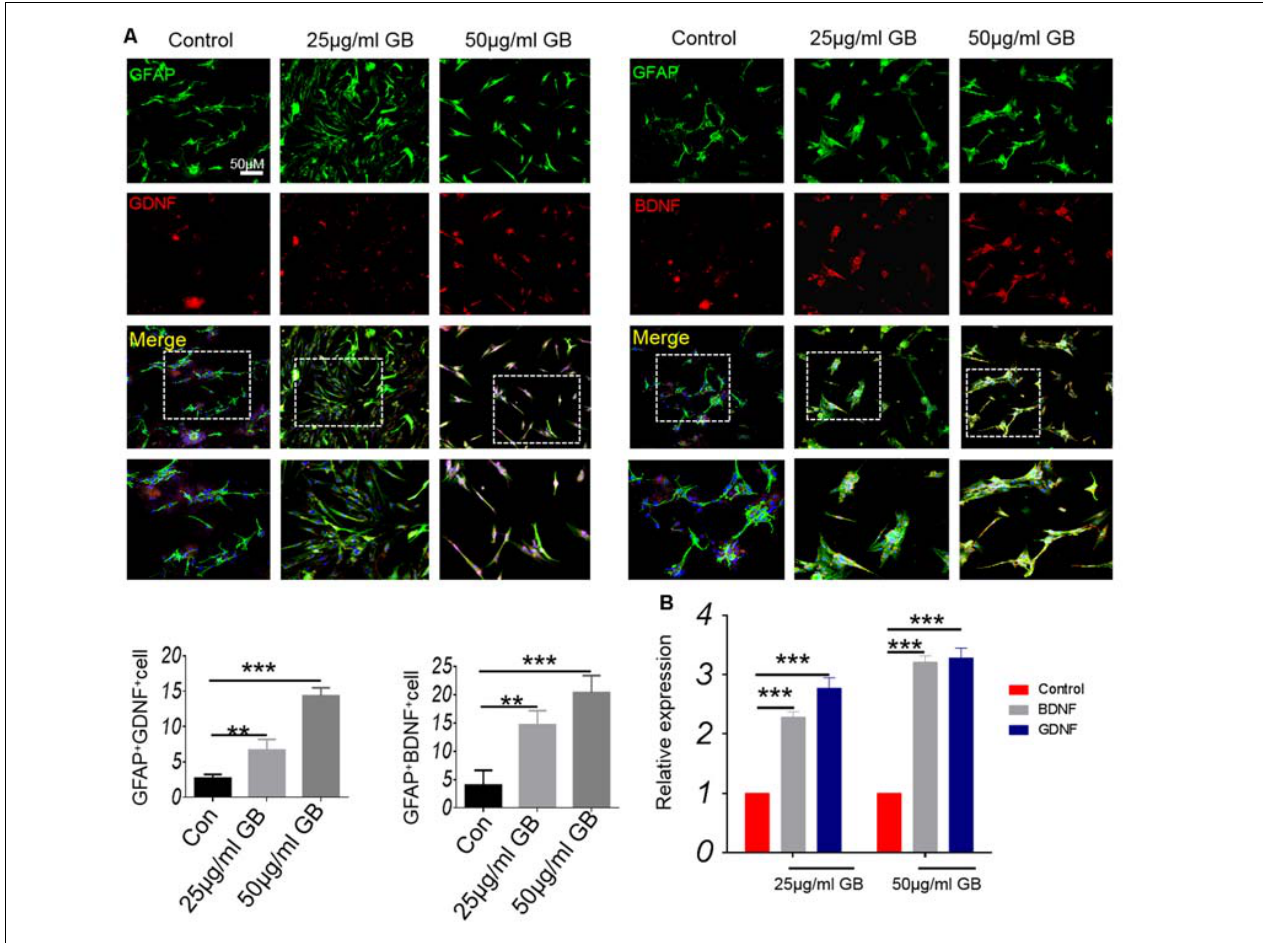
FIGURE 8 | GB promoted the production of neurotrophic BDNF and GDNF in primary astrocytes. (A) Double immunocytochemistry staining with anti-GFAP and anti-BDNF/anti-GDNF in the primary astrocytes. (B) Relative expression of BDNF and GDNF mRNA in the primary astrocytes by qPCR. Representative images are obtained from three replicate samples/each group, with similar results. The results represent the mean ± SEM. ∗∗ p < 0.01, ∗∗∗ p < 0.001.